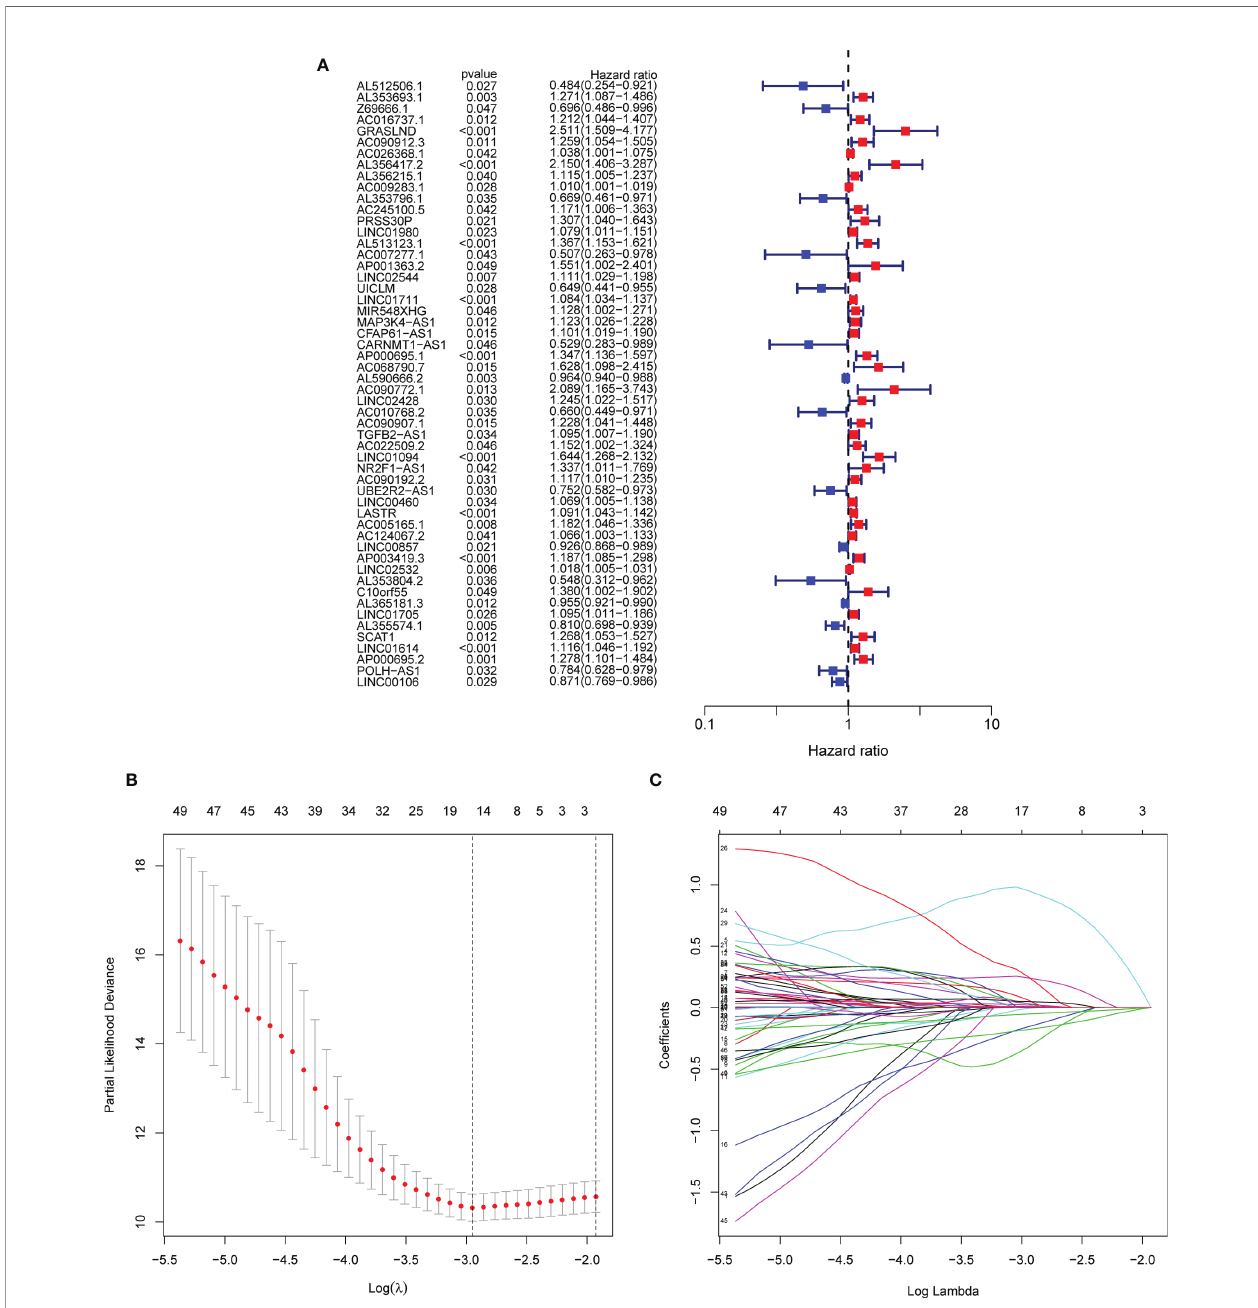
FIGURE 2 | Screening of matrisomal-related lncRNAs and construction of a risk model. (A) Forest plot shows the p -value and the hazard ratio of 54 matrisomal- related lncRNAs via univariate Cox regression analysis. (B) . The change trajectory of each independent candidate variable. (C) . The optimal model was eventually determined when lambda =